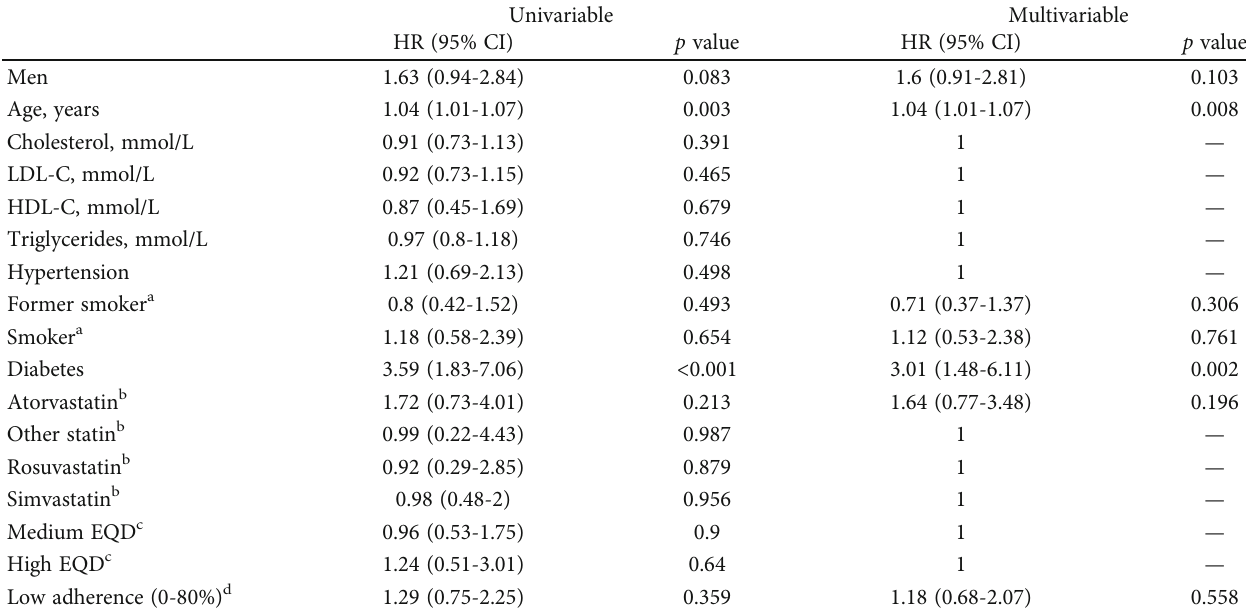
Table 4: Hazard ratios for receiving cardiovascular drug treatment from univariable Cox regression and multivariable regularized Cox regression.